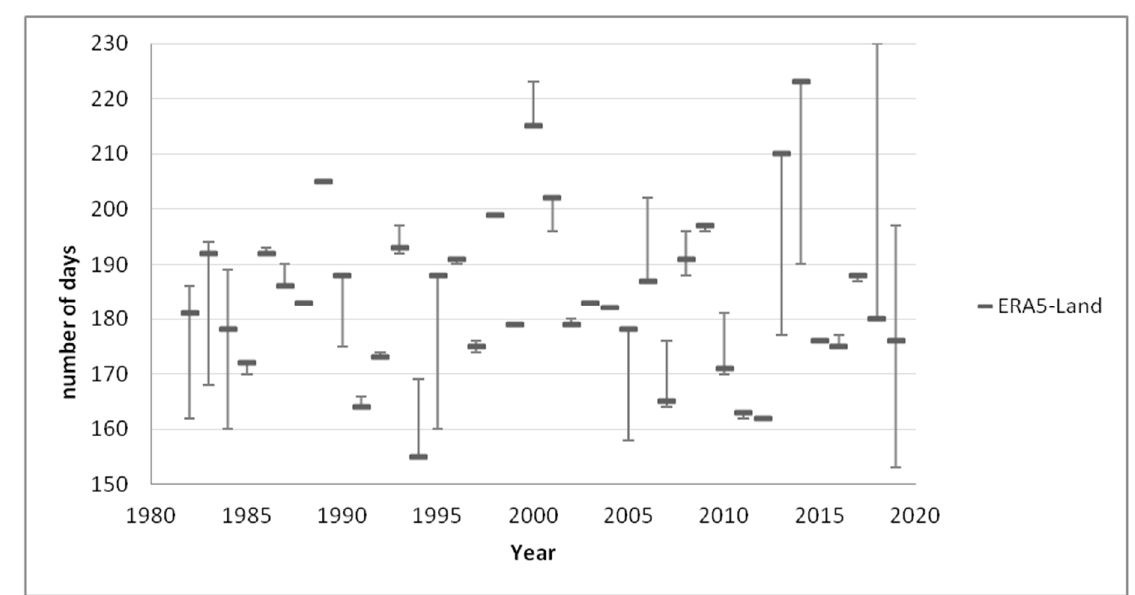
Figure 10. Graph of frost-free periods with uncertainties between the years 1982 and 2019.